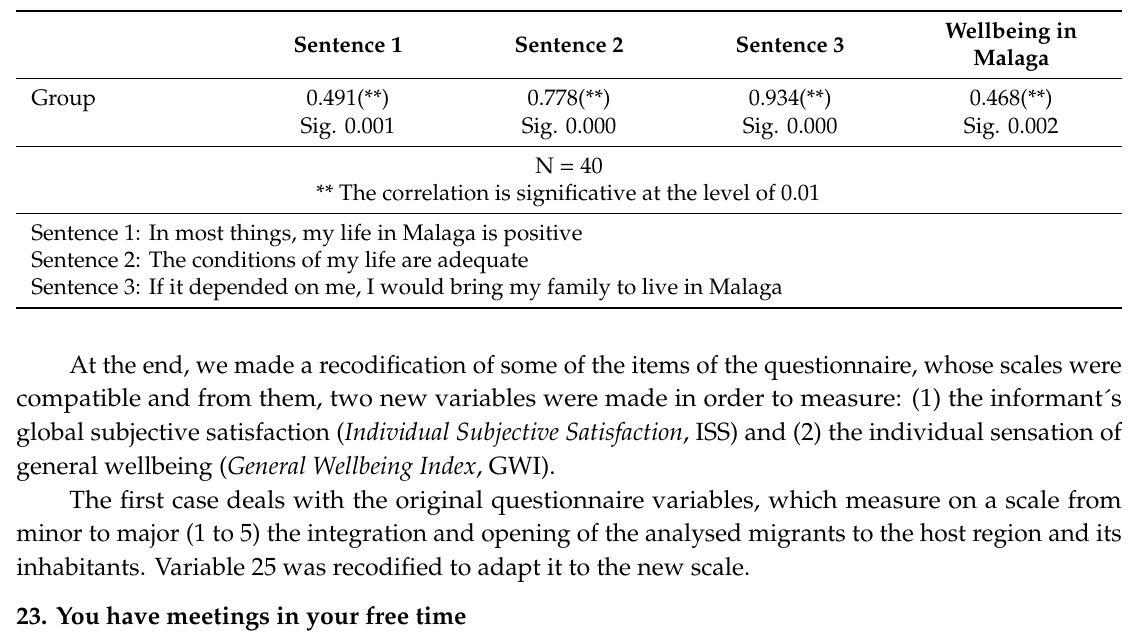
Table 17. Learning group and wellbeing indicators. Spearman